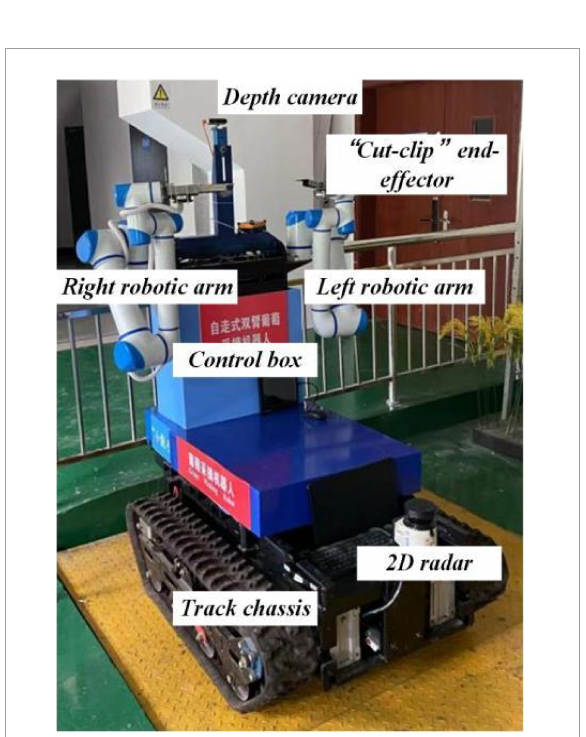
FIGURE2 Dual-arm rapid grape-harvesting